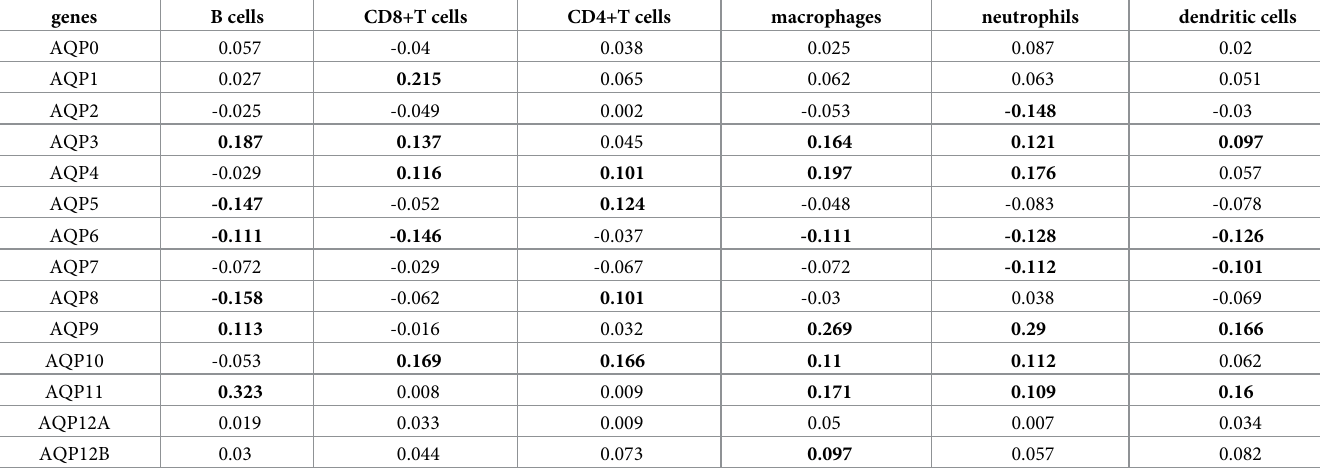
The table showed the associations between individual AQP genes and different immune infiltration by listing the corrected spearman correlation coefficient. The bold values indicated statistical significance (p-value <